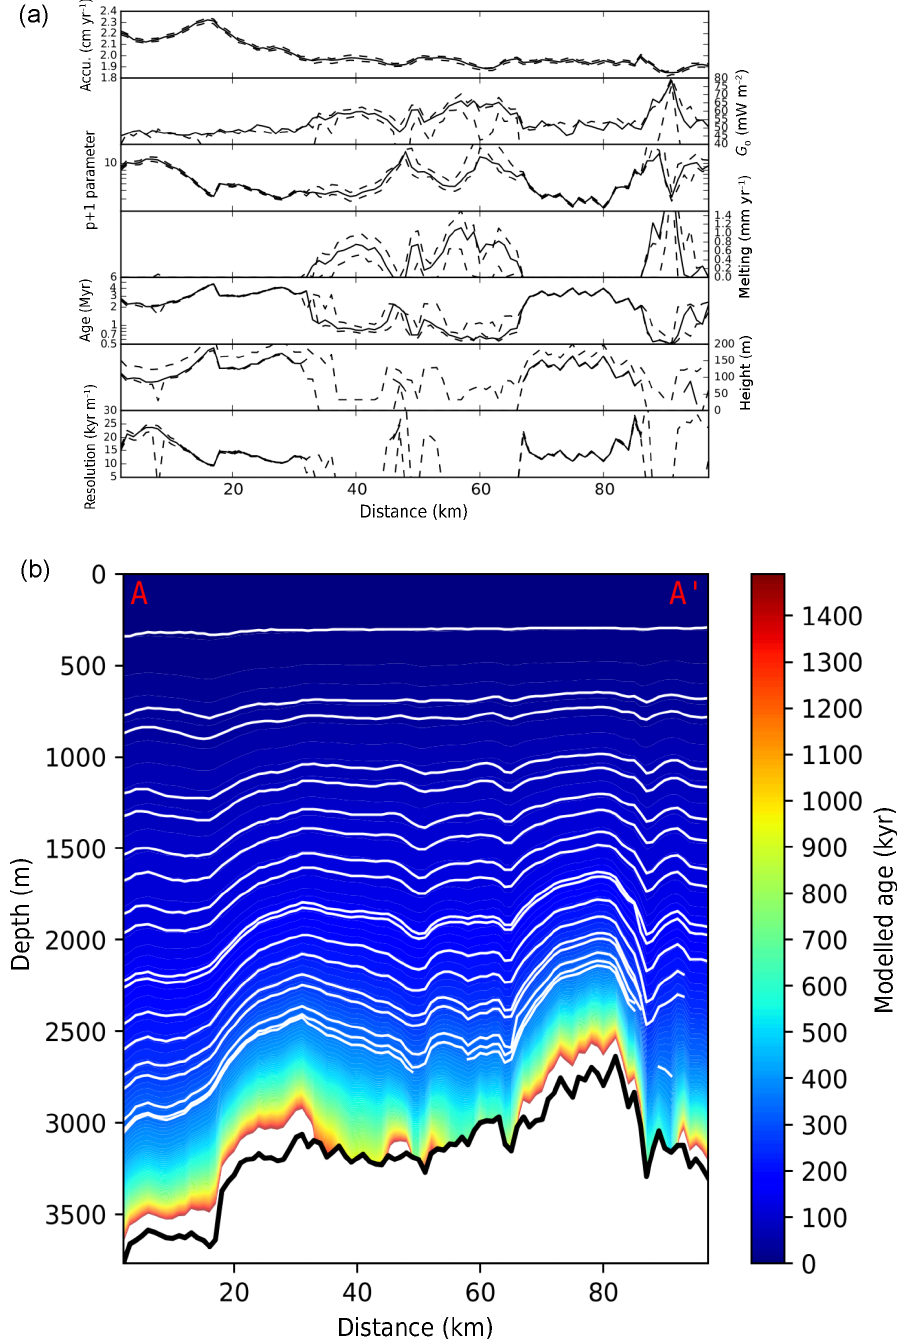
Figure 3. One-dimensional ice flow simulation along the OIA/JKB2n/X45 radar transect (see red dotted line in Fig. 1 for location). (a) Var- ious inferred parameters (plain lines) as well as their 15th and 85th percentiles (dashed lines). From top to bottom panels: average surface accumulation rate, geothermal heat flux, p + 1 parameter of the velocity profile, average basal melting, bottom age 60m above bedrock, height above bed of the 1.5Myr isochrone and resolution of the 1.5Myr isochrone. (b) Modelled age (in colour scale; white is for ages older than 1.5Myr), together with observed isochrones (in white) and bed (in thick black). Note the two main oldest-ice candidates at distance 25km (North Patch, NP) and at distance 75km (Little Dome C Patch,